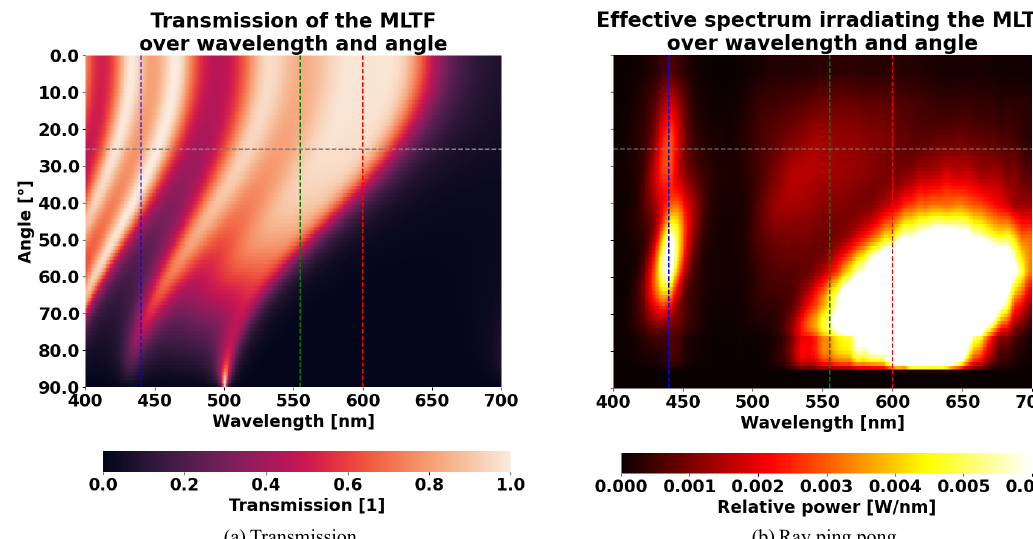
Figure 6. ( a ) Transmission of a multi-layer thin film that exhibits 28.9% more light compared to the reference design in forward direction. ( b ) The hypothetical, effective spectrum of light, which exits the conversion system and irradiates the multi-layer thin film. In both cases, the vertical dashed lines indicate the wavelengths contributing to the LED spectrum and the horizontal lines denote the separation between forward and non- forward